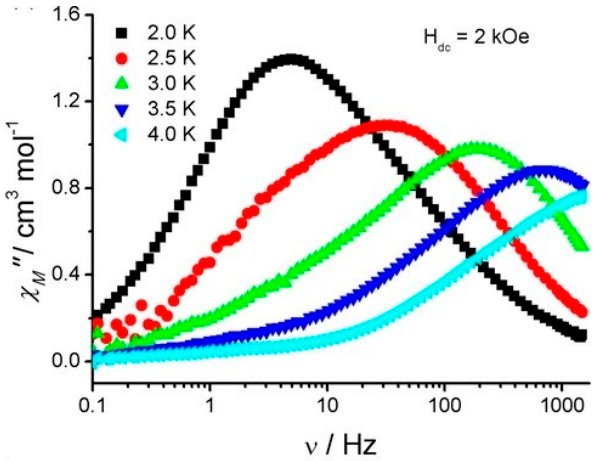
Figure 15. Molecular structures of the two geometrical isomers 27 ( left ) and 27 ʹ ( right ). Figures and captions are reproduced from Reference [54] with permission from the Wiley-VCH.